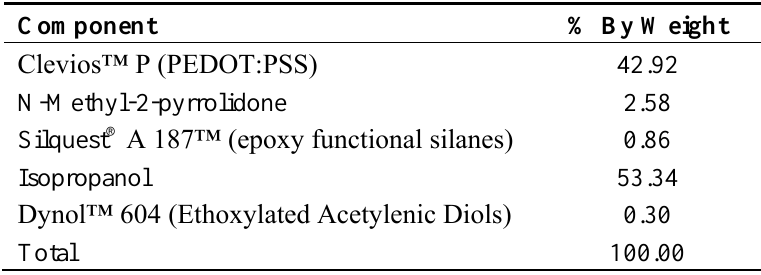
Table 1. Clevios™ coating guide formulation CPP 105D.